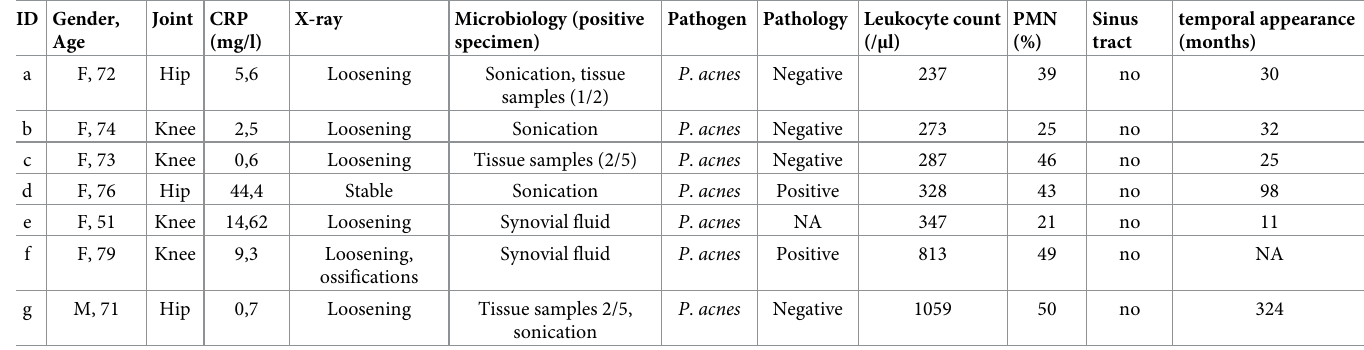
Table 4. PJI with negative leukocyte count in synovial fluid (see Fig 1). CRP, C-reactive protein; PMN, polymorphonuclear cells (granulocytes); NA, not